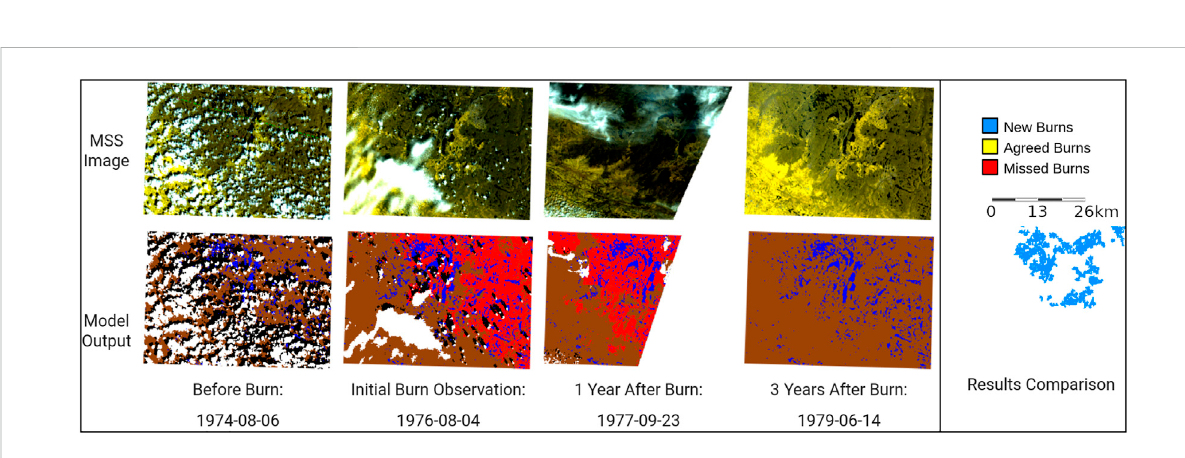
FIGURE 13 Results Detail K. False positive